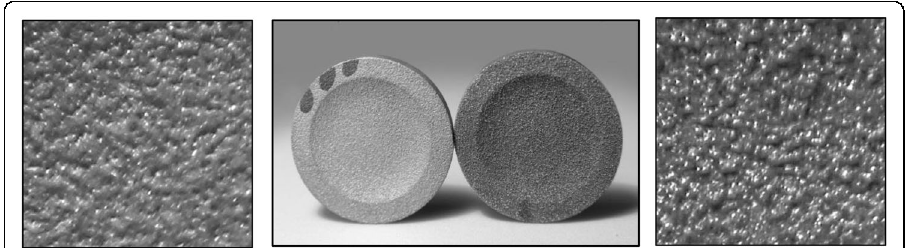
Fig. 15 Photographs of disks produced with (left) and without (right) contour scan